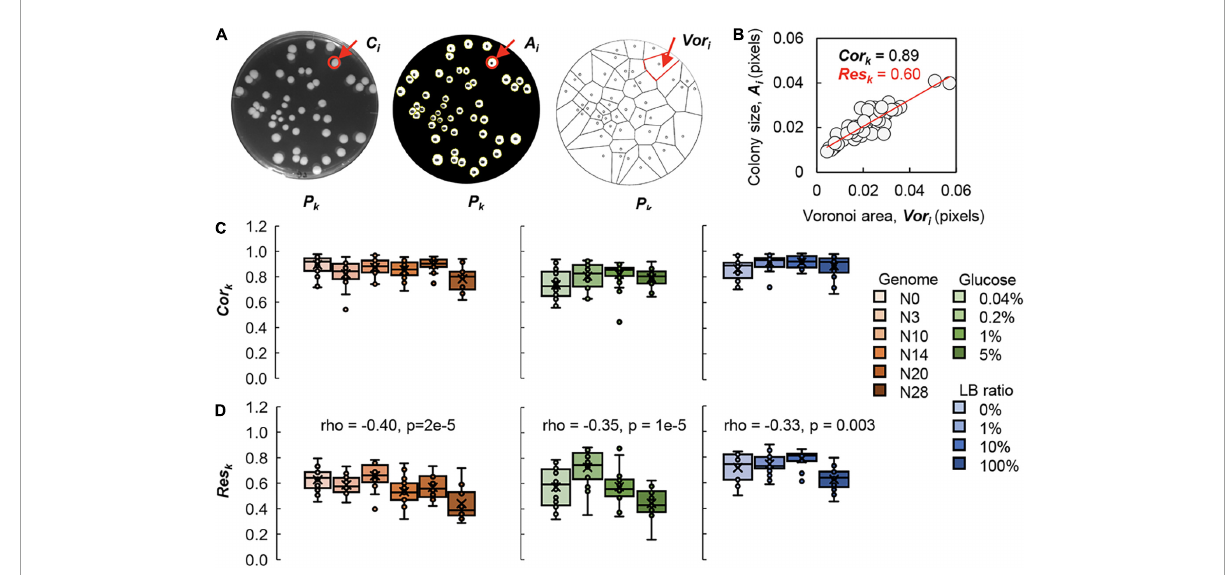
FIGURE4 Voronoi diagram analysis. (A) Image analysis. The original image, the processed image and the Voronoi diagram of the agar plate ( P k ) are shown from left to right as an example. The single colony ( C i ), the corresponding colony size ( A i ) and its Voronoi area ( Vor i ) are indicated by arrows and highlighted in red. (B) Evaluation of Voronoi correlation and Voronoi response. The Voronoi correlation ( Cor k ) and Voronoi response ( Res k ) are defined as the correlation coefficient and the slope of linear regression of the relative Voronoi area and the relative colony size, respectively. As an example, the values of Cor k and Res k are indicated in black and red, respectively. Circles represent the colonies ( N = 47). (C) Relationships of Cor k to the genome size and nutritional gradient. Boxplots of Cor k acquired from each plate are shown. (D) Correlations of Res k to the genome size and nutritional gradient. Boxplots of Res k acquired from each plate are shown. Tiny circles represent the Cor k of individual plates of 25–75 colonies. The crosses indicate the average of Cor k . Gradations in orange, green and blue indicate the genome size from the wild type to the reduced ones ( N = 111), the concentration gradient of glucose in the minimal medium M63 ( N = 78) and the ratio gradient of LB in the mixed medium M63LB ( N = 80). Spearman’s correlation coefficients and the p -values are